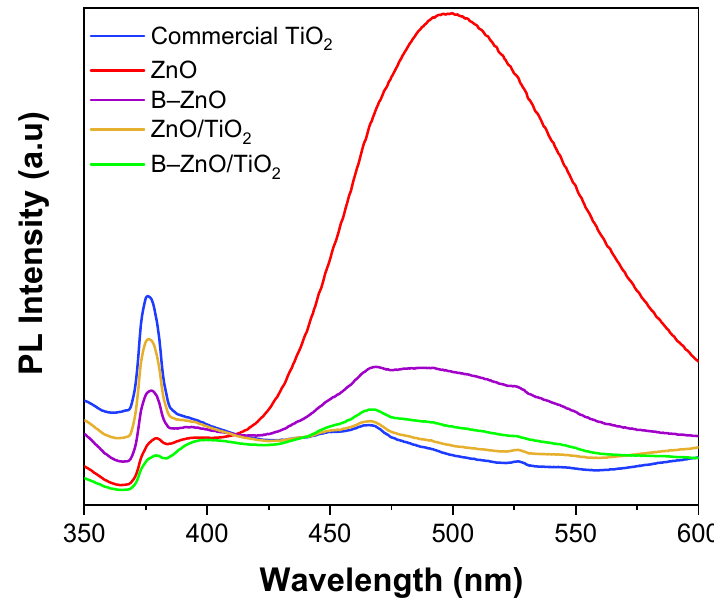
2 , ZnO, and B–ZnO/TiO 2 .